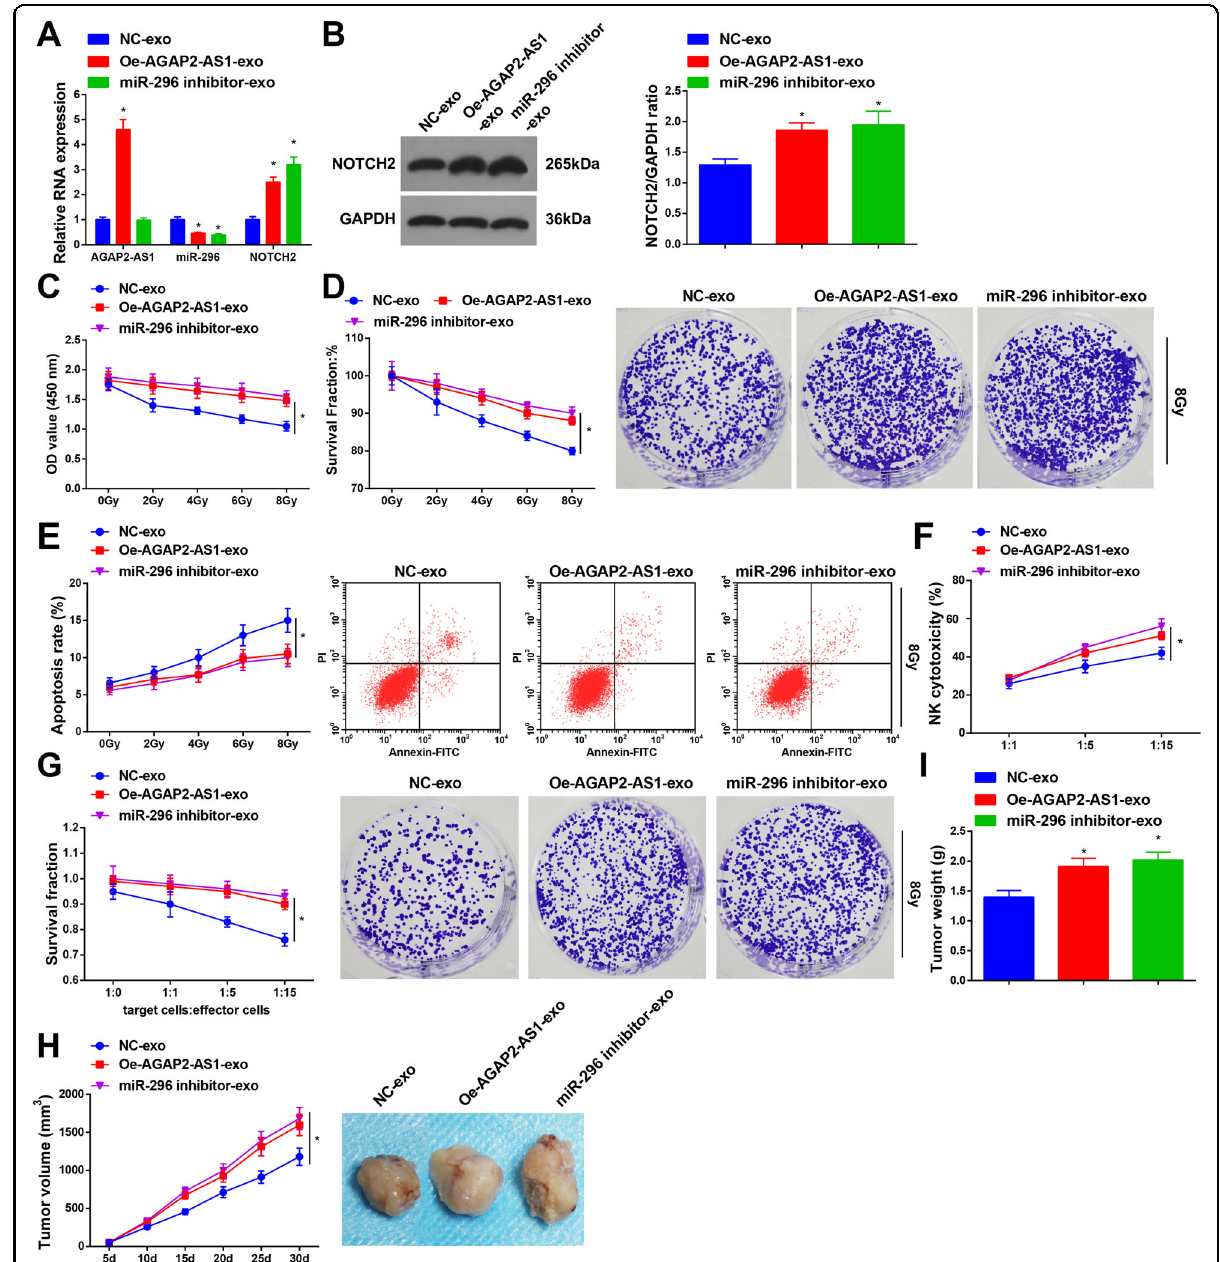
Fig. 6 Macrophage-derived exosomes overexpress AGAP2-AS1 or reduce miR-296 to strengthen radioresistance of radioresistant lung cancer cells. A Expression of AGAP2-AS1, miR-296, and NOTCH2 in A549R26-1 cells was detected by RT-qPCR. B Protein expression of NOTCH2 in A549R26-1 cells was determined by Western blot analysis. C Viability of radioresistant lung cancer cells A549R26-1 was measured using CCK-8 assay. D Colony formation ability of radioresistant lung cancer cells A549R26-1 was evaluated by colony formation assay. E Apoptosis of radioresistant lung cancer cells A549R26-1 was determined by fl ow cytometry. F NK cells-mediated cytotoxicity against radioresistant lung cancer cells A549R26-1 was detected by LDH cytotoxic assay. G NK cells-mediated cytotoxicity against radioresistant lung cancer cells A549R26-1 was detected by colony formation assay. H Volume of xenografts from nude mice that had been injected with radioresistant lung cancer cells A549R26-1. I Weight of xenografts from nude mice that had been injected with radioresistant lung cancer cells A549R26-1; N = 3 in the cellular experiment and n = 6 in the animal experiment; * P < 0.05 vs. the NC-exo group; the measurement data were expressed as mean ± standard deviation, one-way ANOVA was used for comparisons among multiple groups and Tukey ’ s post hoc test was used for pairwise comparisons after one-way ANOVA.